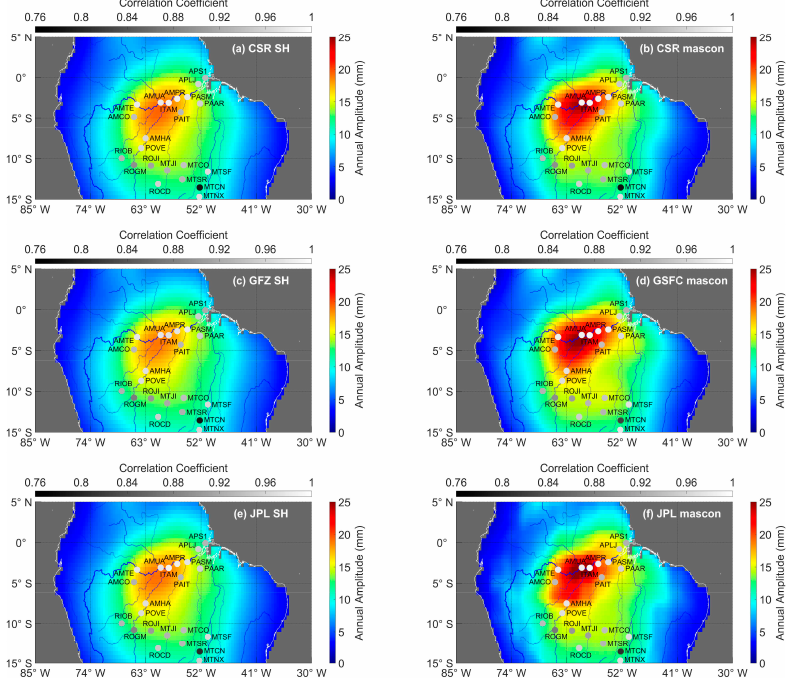
Figure 4. The correlation coefficients between the vertical displacements derived from GRACE/GRACE-FO ( a ) CSR SH, ( b ) GFZ SH, ( c ) JPL SH, ( d ) CSR mascon, ( e ) GSFC mascon and ( f ) JPL mascon, and those observed by GNSS at the 22 GNSS stations. The gray scales of the round dots represent the values of the correlation coefficients. The background colors denote the same as in Figure 3. The correlation coefficient is used to evaluate the correlation between two time series, Remote Sens. 2023 , 15 , 252 12 of 21 which focuses more on the characteristics of the temporal variations but less on the am- plitudes of the signals. The RMS reduction, which has been widely used in previous stud- ies, is used here to estimate the agreement between two time series. Figure 5 shows the RMS reductions when GRACE/GRACE-FO derived displace- ments are removed from the GNSS height time series. The gray scales of the round dots represent the values of RMS reductions. The mean RMS reductions of the six GRACE/GRACE-FO products are listed in the 8th column, for CSR SH, GFZ SH, JPL SH, CSR mascon, GSFC mascon and JPL mascon, respectively, the results of 3 mascon prod- ucts are a little larger than that of three SH products in the central Amazon Basin, but the differences become much more significant when removing the AMCO station, whose re- sult seems to be abnormal. Overall, the values at all the 22 stations are positive, which means that the GNSS height variations can be explained by mass loading effects to a cer- tain extent in this region. Furthermore, the RMS reductions are relatively larger in the central Amazon Basin, and relatively smaller in the southern Amazon Basin. This spatial feature is more apparent for the stations near the Amazon River using GRACE/GRACE- FO mascon products (e.g., AMTE, AMUA, ITAM and AMPR in Figure 5b,d,f), which sug- gests that the observations from the mascon products might be more informative in re- flecting spatial patterns than the SH products do.